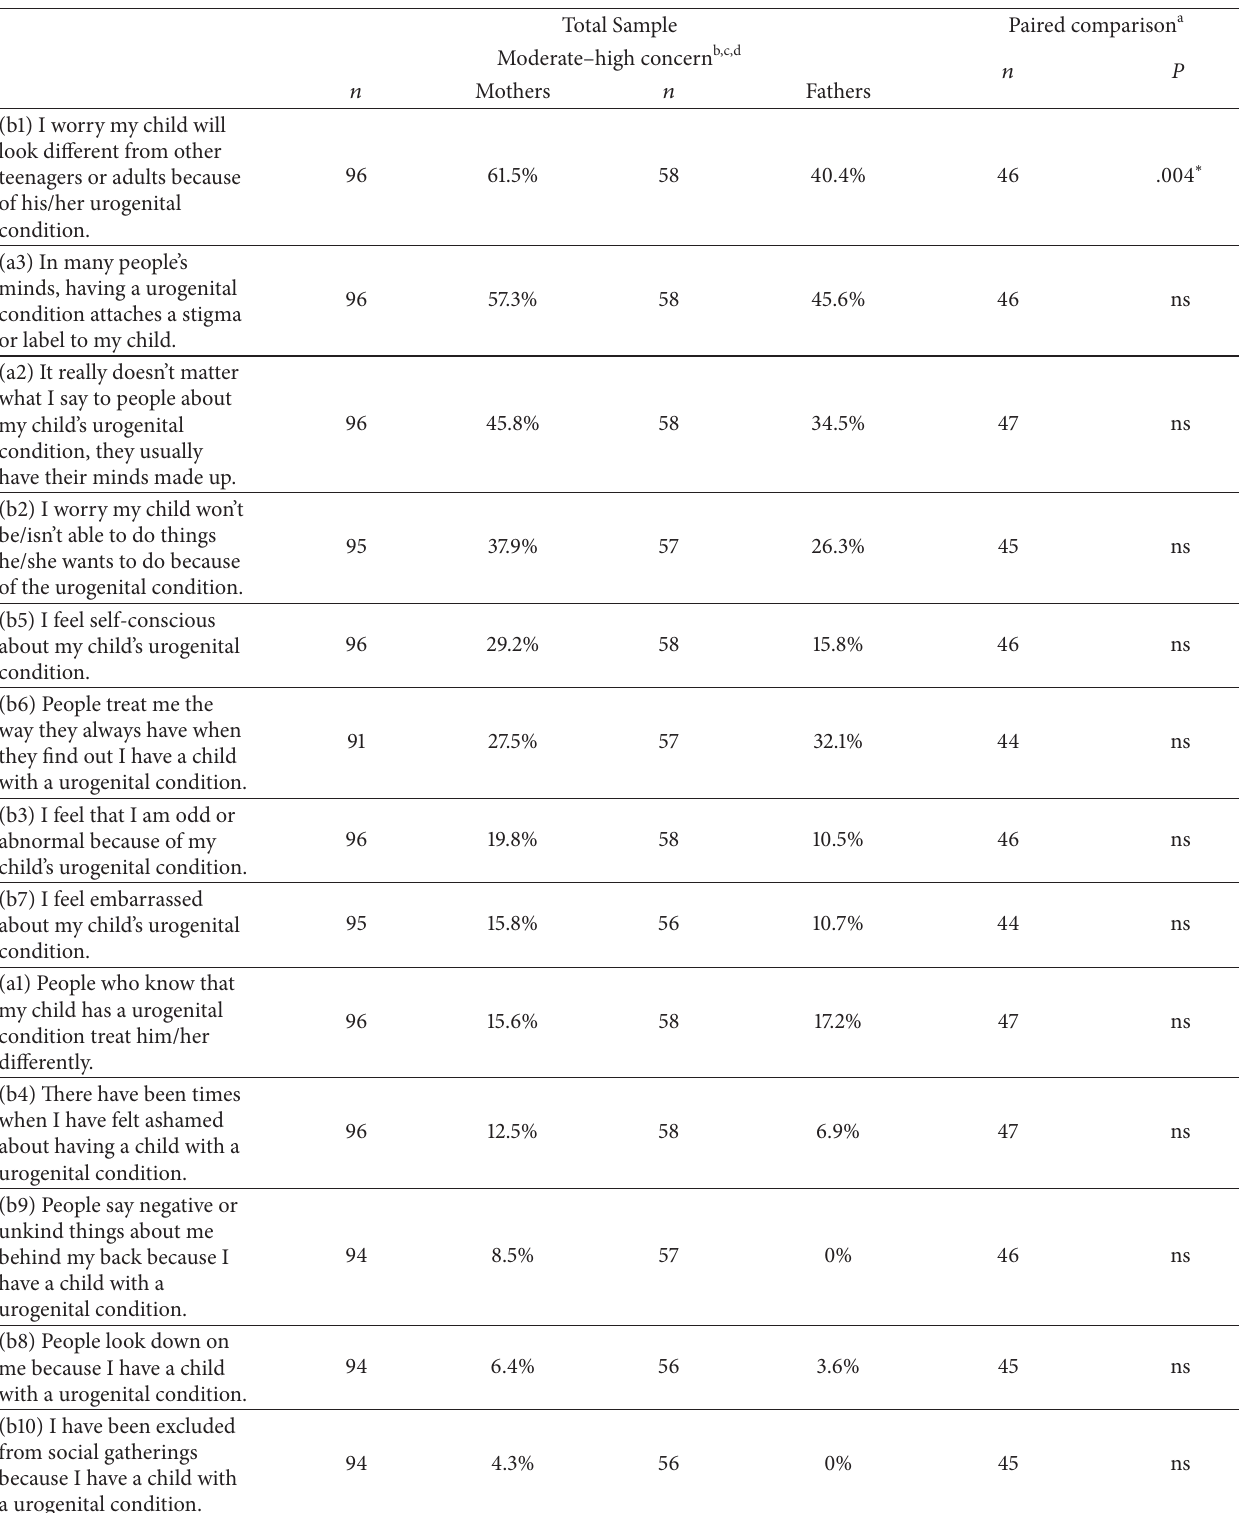
Table 5: Frequency of moderate to high concern on individual items reported by mothers and fathers and informant comparisons, ordered by highest percentage in the mother’s